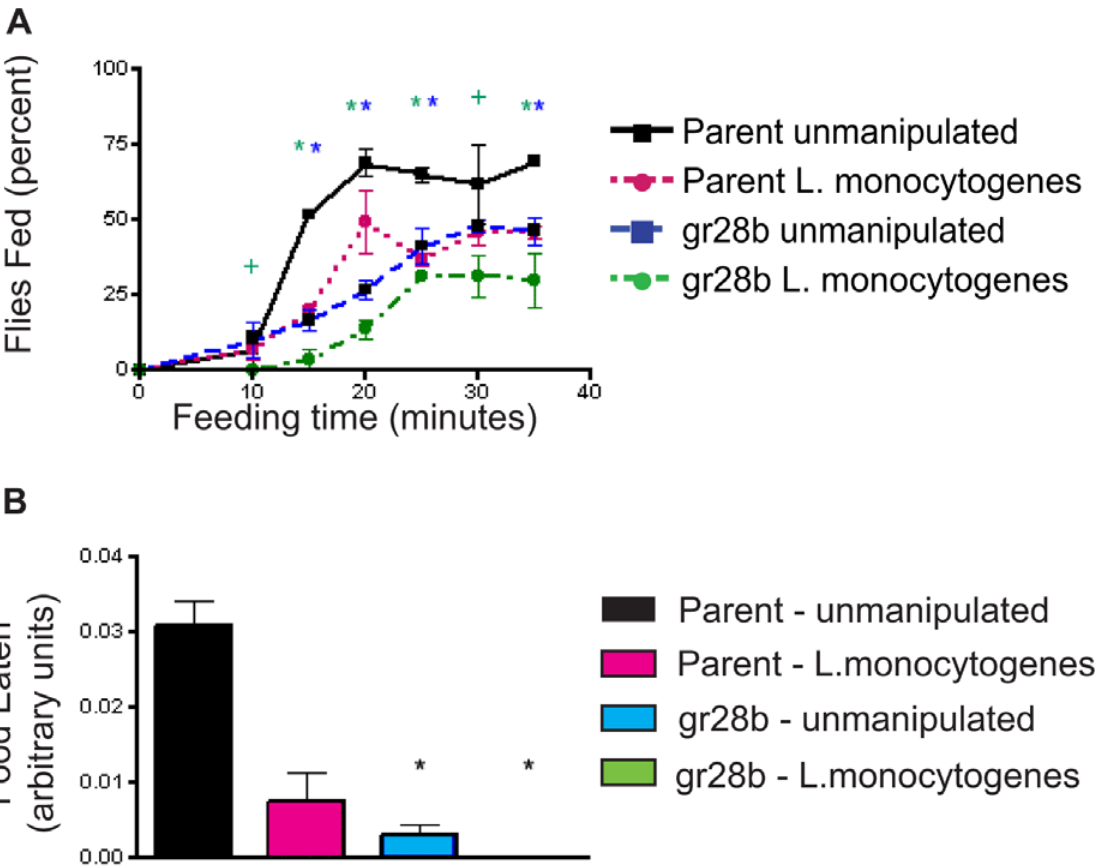
Figure 2. Effect of mutation of the gustatory receptor gr28b on appetite. Isogenic wild-type and gr28b mutants were assayed for feeding rates (A) and meal volumes (B). Error bars indicate standard error of the mean. Statistical analysis for (A) was done using a Fisher’s exact test. Green asterisk indicates Listeria -infected gr28b mutants are significantly different than unmanipulated wild-type flies. Blue asterisks indicate that unmanipulated gr28b mutants are significantly different than unmanipulated wild-type flies. Green crosses indicate that Listeria -infected mutants are significantly different from unmanipulated wild-type flies only. Actual p -values are listed in Table S4. Statistical analysis for (B) was done using ANOVA and a Tukey post-test. Black asterisk indicates p , 0.001 compared to unmanipulated wild-type flies.